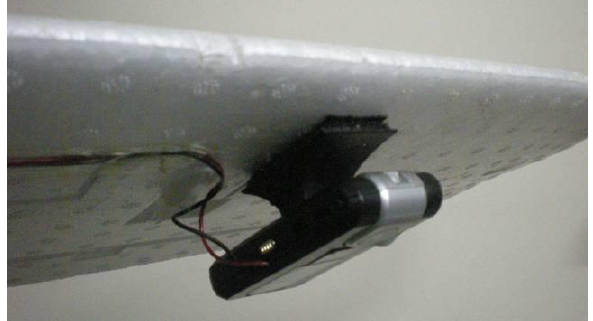
Figure 5. The camera under the left wing